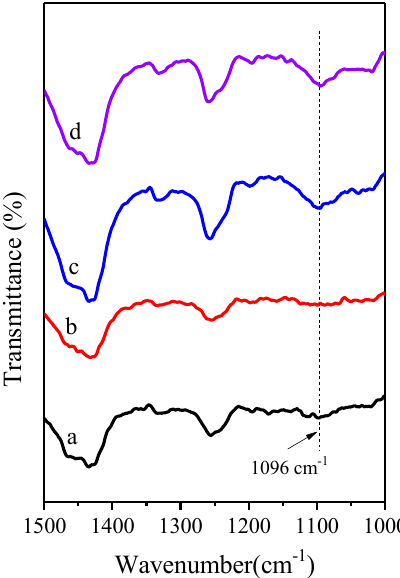
Figure 8. FT-IR spectra of pure PVC and PVC stabilized by DMAE-Zn and heated at 180 °C. Initial pure PVC sheet ( a ); pure PVC sheet heated for 30 min ( b ); initial PVC sheet stabilized by DMAE-Zn ( c ); PVC sheet stabilized by DMAE-Zn heated for 30 min ( d ).